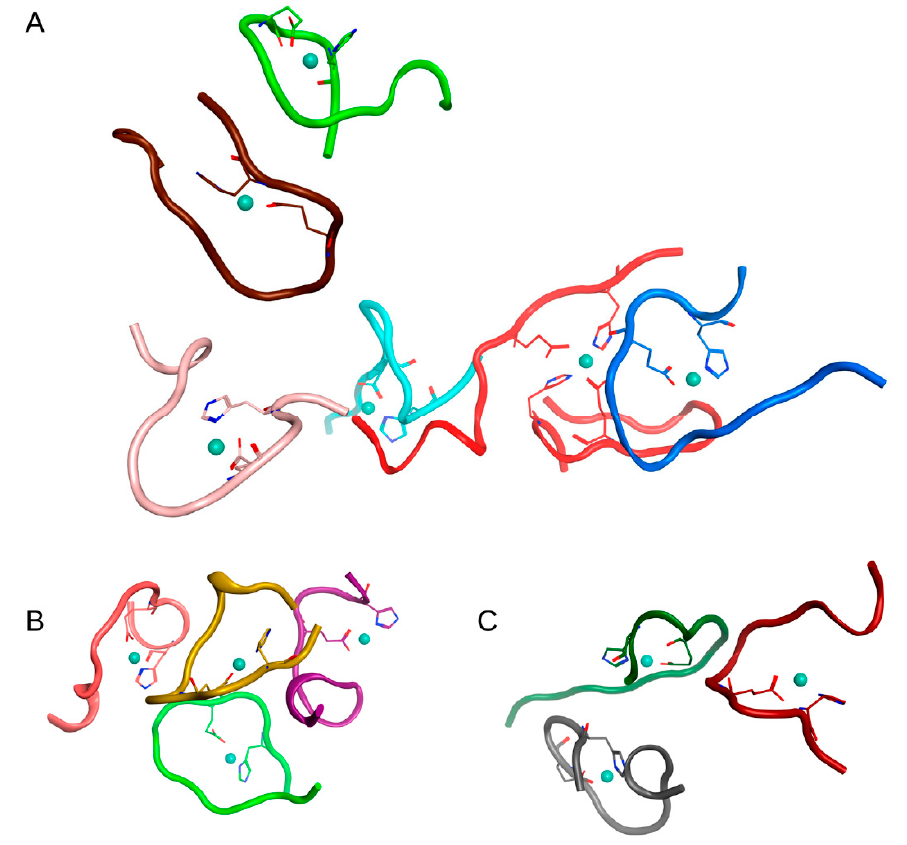
Figure 2. Results of 100 ns MD simulation of the A β 16 System 1 from Table 1 (C zn > C A β ). Three large clusters are shown ( A – C ). Box size is 15 nm. The A β 16 molecules are shown with different colors. Zinc coordinating side chains are shown. Zinc ions are highlighted in blue. The A β 16 dimer (bottom right corner in A ) is colored